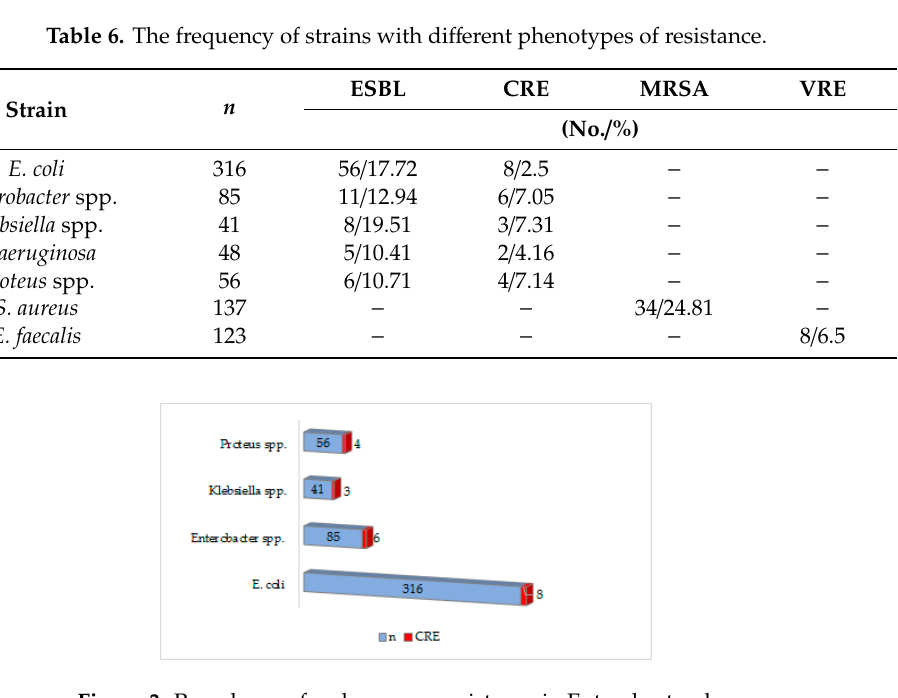
Figure 3. Prevalence of carbapenem resistance in Enterobacterales.